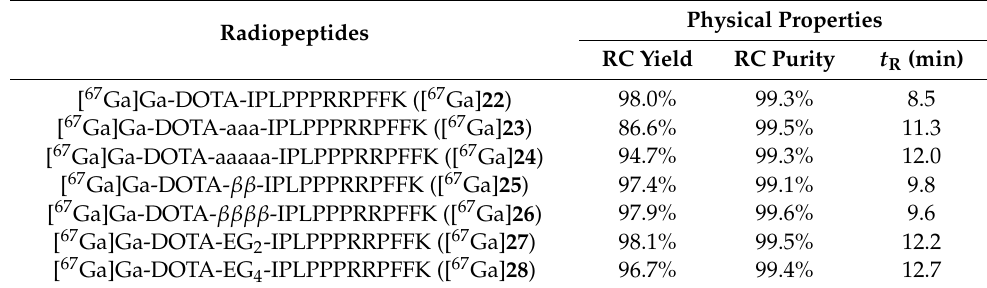
Table 1. Quality control results for [ 67 Ga]Ga-DOTA-(linker)-IPLPPPRRPFFK. Radiopeptides